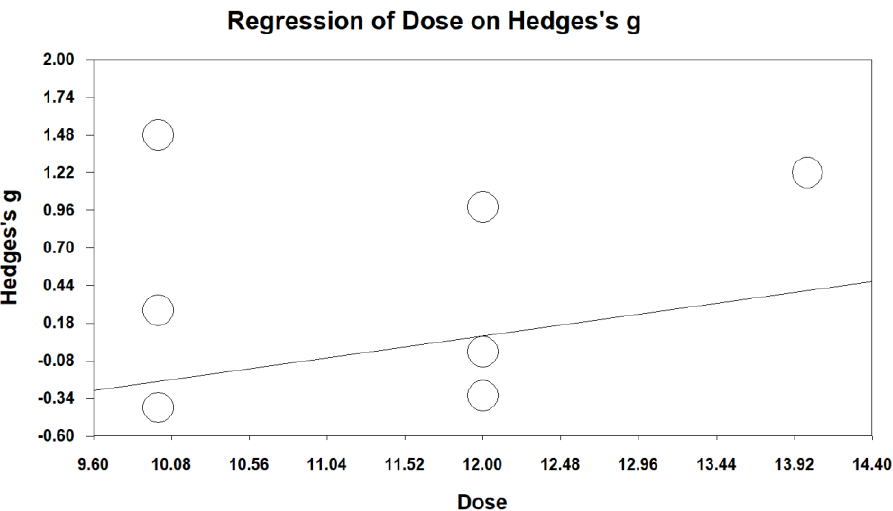
Figure 5. Meta-regression analysis assessing the dose effect of VR-based exposure therapy on PTSD symptoms.